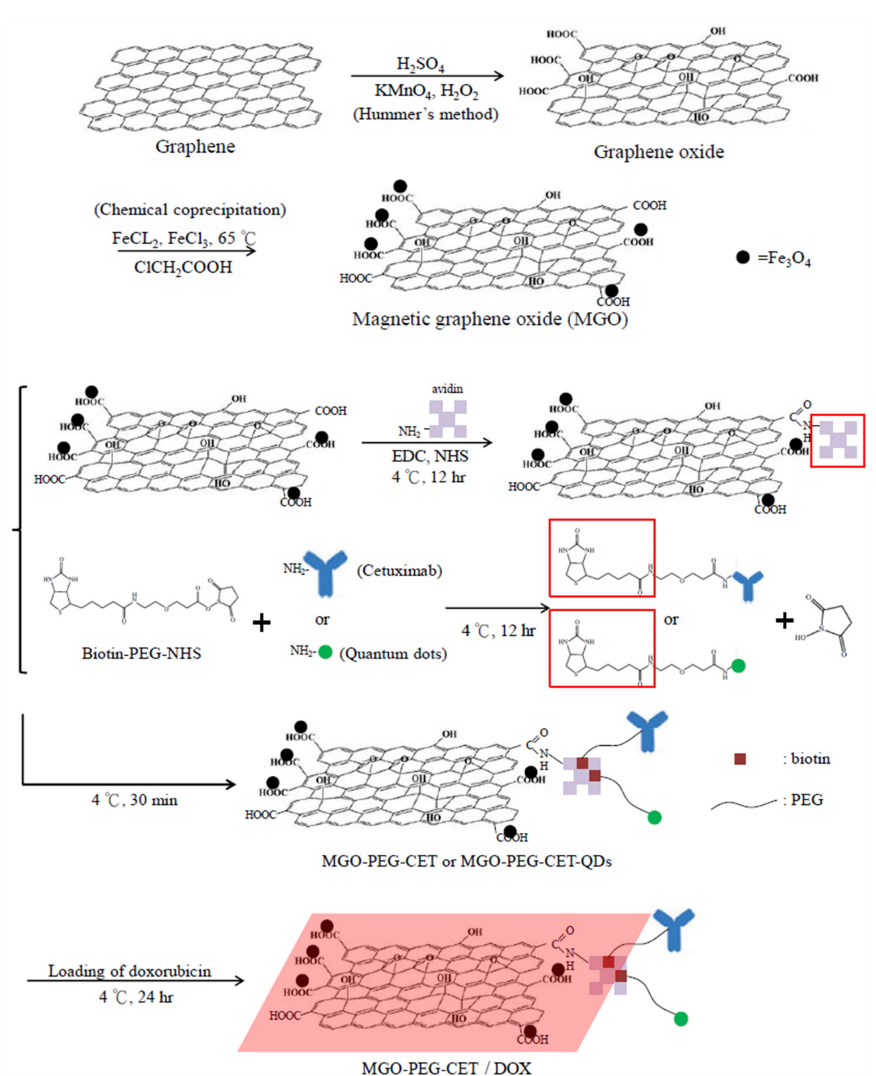
Figure 1. The flow diagram for producing doxorubicin (DOX)-loaded Magnetic Graphene Oxide (MGO)-polyethylene glycol (PEG)-cetuximab (CET) (MGO-PEG-CET/DOX). Fe 3 O 4 magnetic nanoparticles were deposited on GO by chemical co-precipitation to prepare MGO. Avidin was bound to MGO by covalent binding while biotin-PEG N-hydroxysuccinimide (NHS) was conjugated to cetuximab (CET) or quantum dots (QDs). Mixing of avidin-modified MGO with biotin-PEG-CET and biotin-PEG-QDs could produce MGO-PEG-CET and MGO-PEG-CET-QDs for doxorubicin (DOX) loading and fluorescent tracking after intracellular